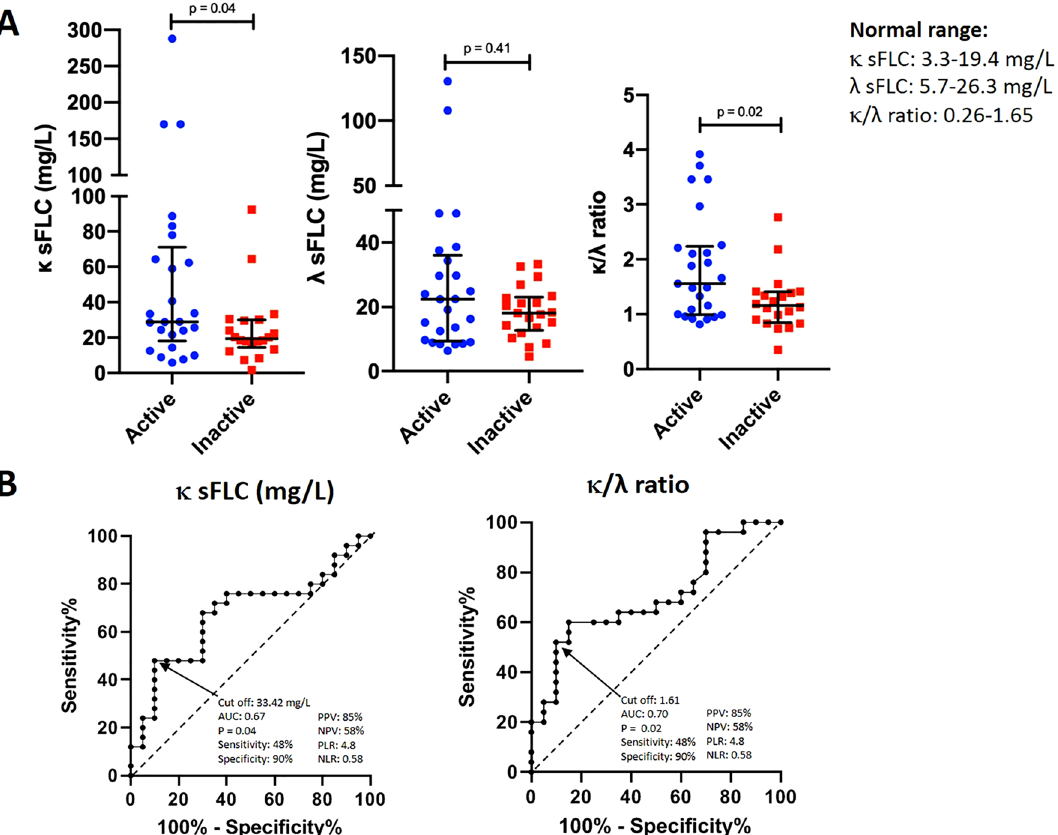
Figure 6. ( A ) Levels of κ serum free light chains and the κ/λ ratio were different between active (n = 25) compare to inactive (n = 20) IgG4-related disease patients (median with interquantile range). Statistics performed by Mann–Whitney U test. ( B ) The receiver operating characteristic curve for κ serum free light chains and the κ/λ ratio distinguished patients with active from inactive disease. sFLC serum free light chains, PPV positive predictive value, NPV negative predictive value, PLR positive likelihood ratio, NLR negative likelihood